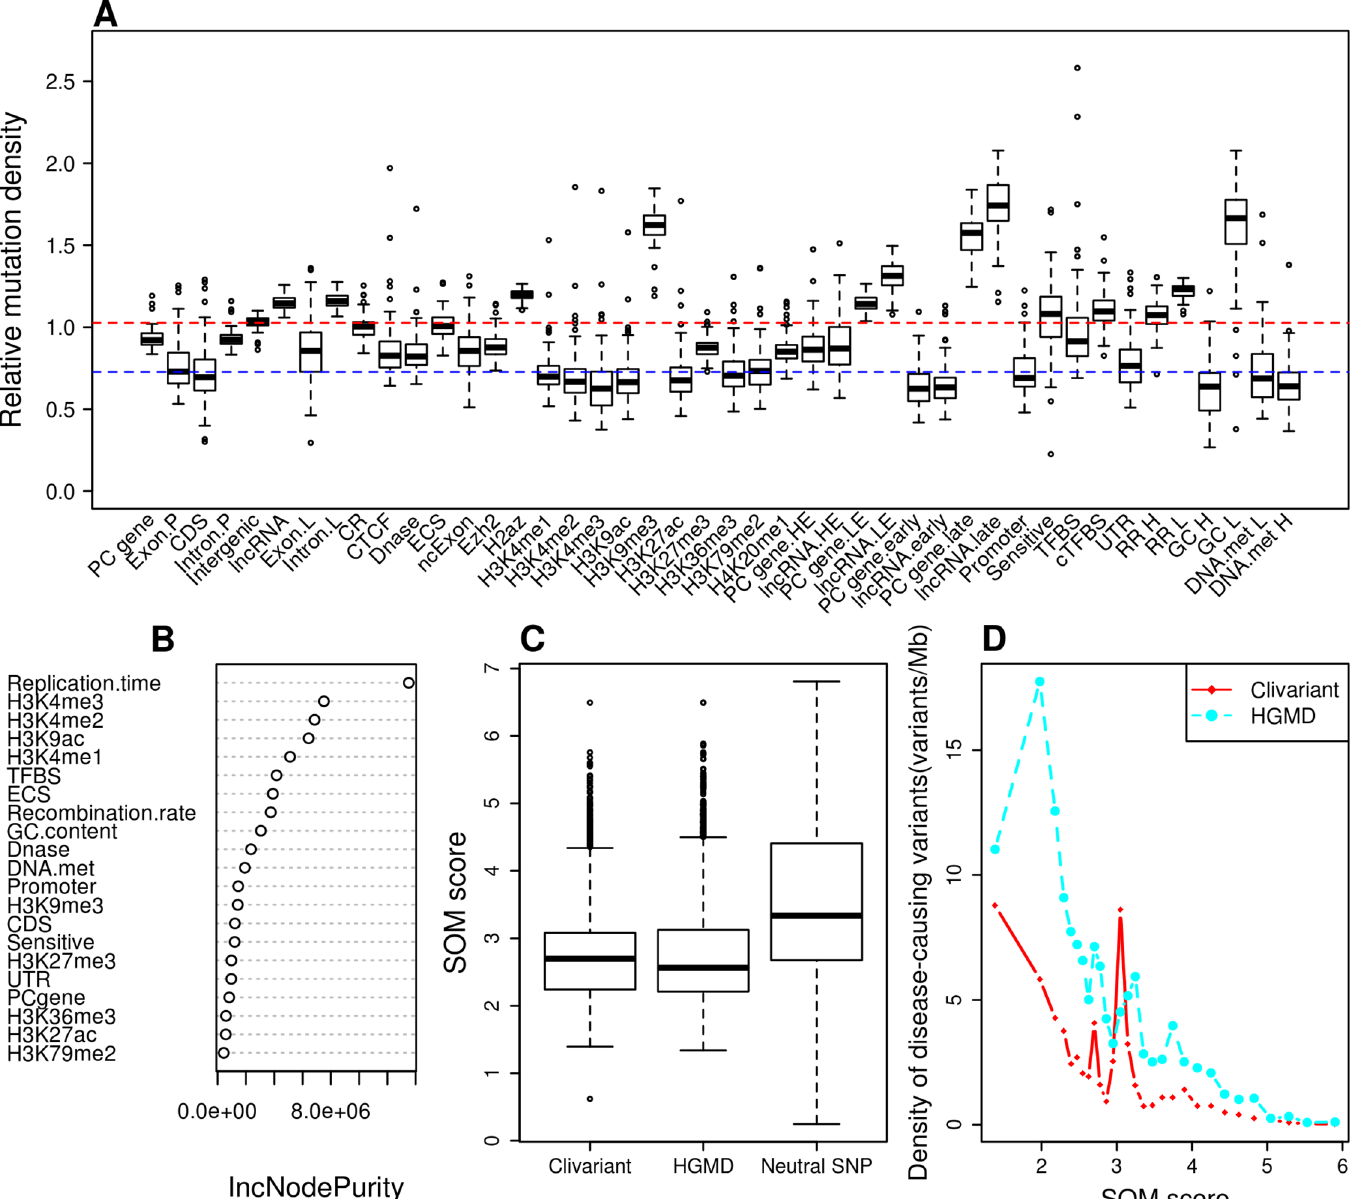
Fig 2. Construction of the Somatic Mutation (SOM) model for liver cancer. A . Relative density of somatic mutations from whole genome sequences of 88 liver tumors [11], associated to different genome features (see Methods for feature details). Mutation density is normalized so that the whole genome average has a mutation density of 1. PC gene: protein coding gene; CDS: coding sequence; Exon.P, Intron.P, Exon.L,Intron.L are exon and intron of protein coding gene and lncRNA respectively; CR: conserved region; DNase: DNase I hypersensitive site; ECS: evolutionarily conserved structure; ncExon: non- coding exon; PC gene.HE, LncRNA.HE, PC gene.LE and LncRNA.LE are high expressed and low expressed protein coding gene and lncRNA; PC gene. early, LncRNA.early, PC gene.late and LncRNA.late are early and late replicated protein coding gene and lncRNA; cTFBS: conserved transcription factor binding site;RR H,RR L,GC H,GC L,DNA.met H and DNA.met L are 1-Kb windows with high recombination rate ( > 4.0), low recombination rate ( < 0.5), high GC content (GC % > 50%), low GC content (GC% < 30%), high DNA methylation (average value > 0.7245) and low DNA methylation (average value < 0.4062) respectively; Blue and red dotted lines: base lines showing average values for CDS and intergenic regions, respectively; B: Feature importance as measured by IncNodePurity. We only show here features that passed feature selection. C . Distribution of SOM scores for neutral SNPs and for clinical variants from two disease-causing variants databases Clivariant and HGMD. Neutral SNPs here are SNPs from the 1000 Genome project with allele frequency higher than 0.01, SOM scores predicted by the random forest model were divided by the number of patients. D . Correlation of SOM score with densities of disease-causing variants. Genome positions were sorted by SOM score and split into 100Mb intervals. The plots show the average SOM score and density of disease-causing variants for each interval. The purple dotted line shows cutoff used for defining low SOM score thereafter.